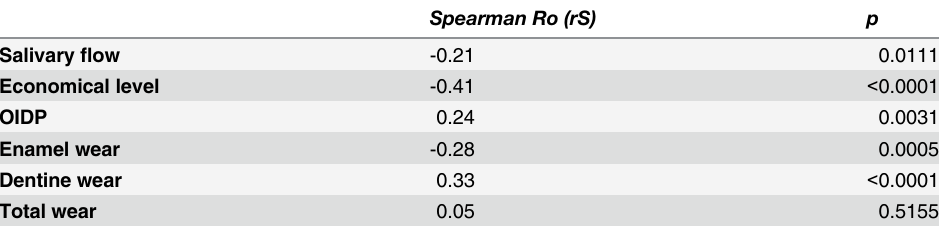
Table 3. Correlation among BMI and the other factors